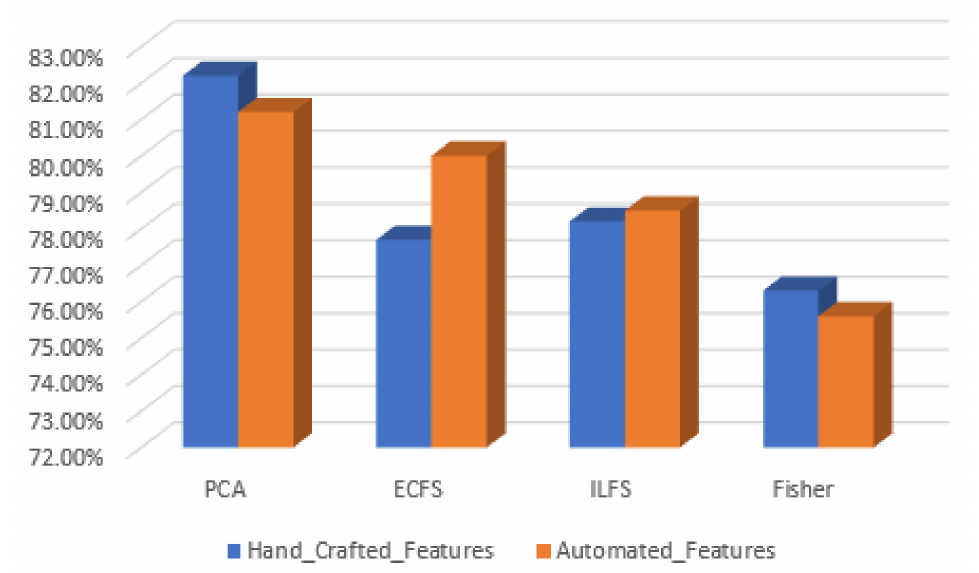
Figure 29. Accuracy for the 30 most significant features for severity grading in both automated and hand-crafted